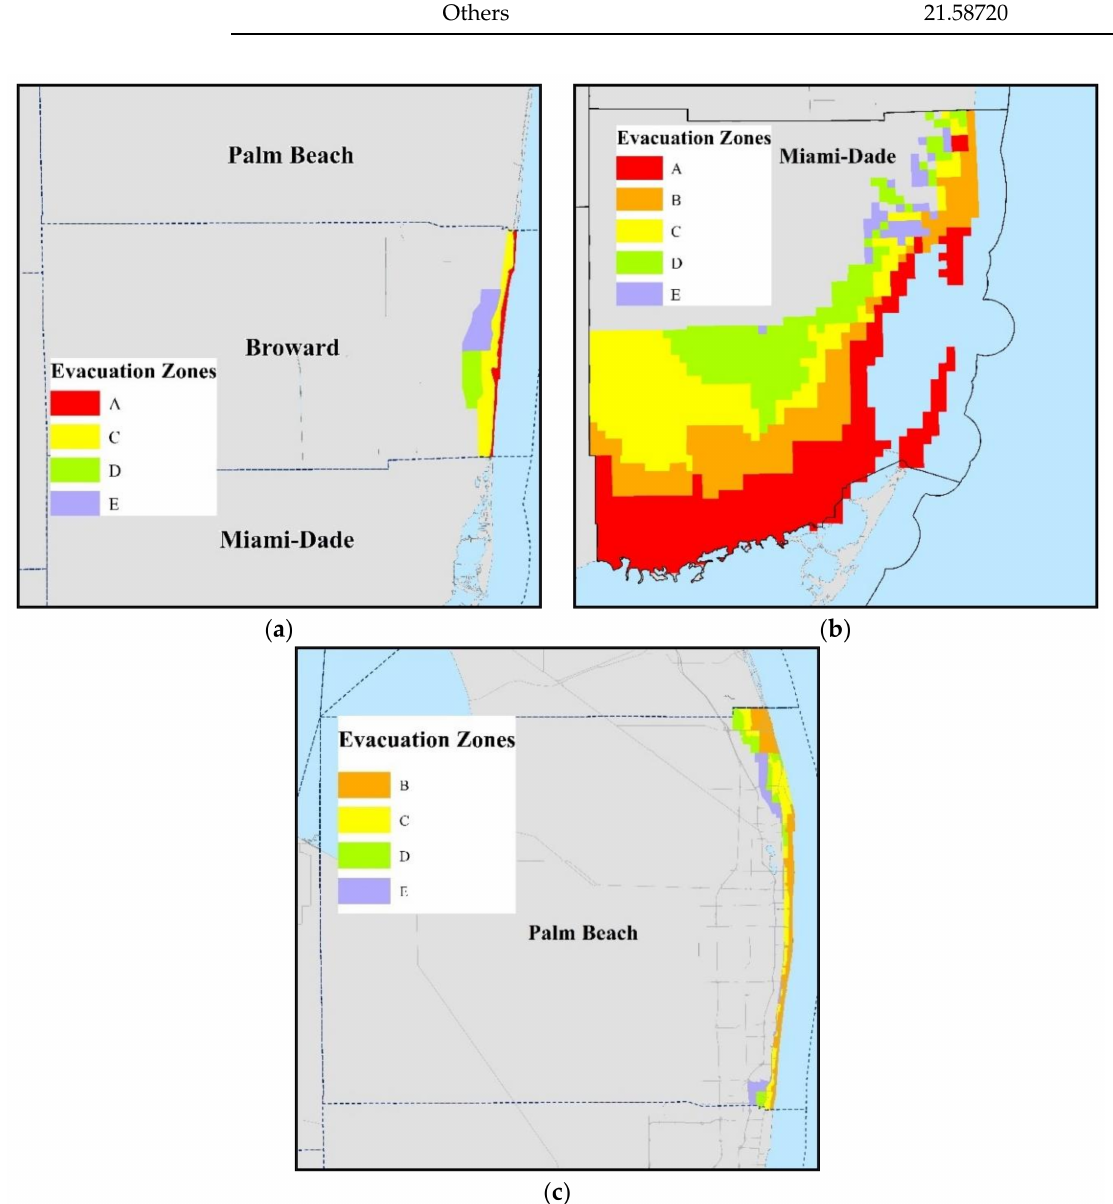
Figure 5. Evacuation Zones ( a ) Broward; ( b ) Miami-Dade; ( c ) Palm